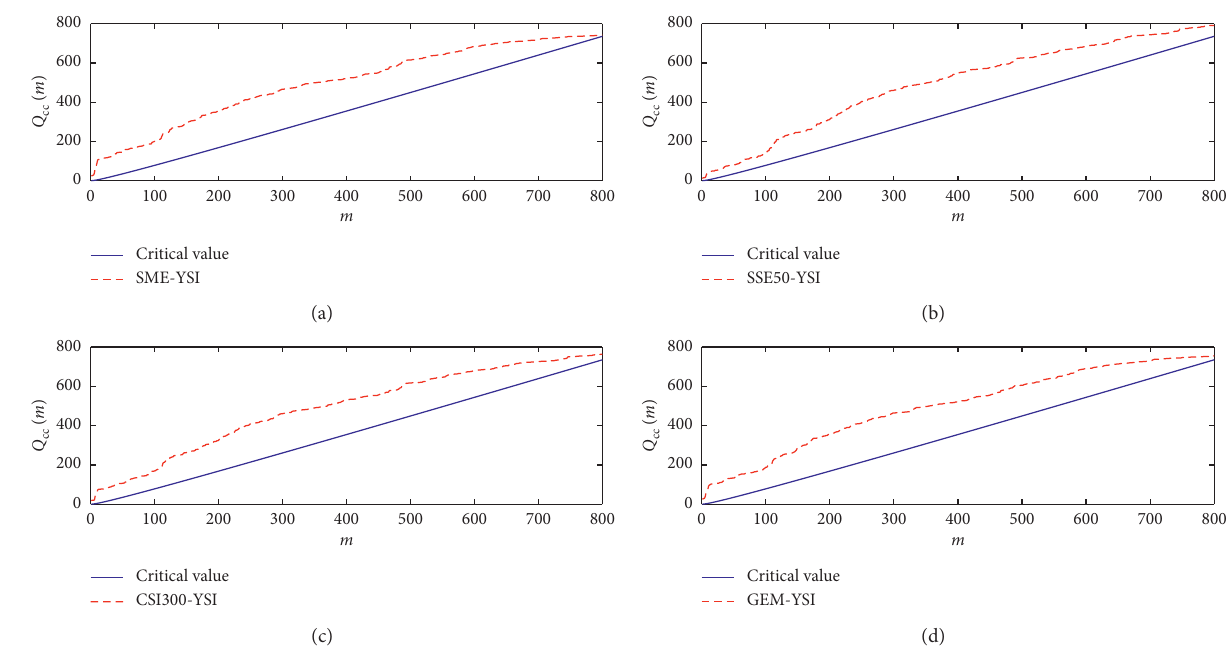
Figure 2: The cross-correlation statistic Q